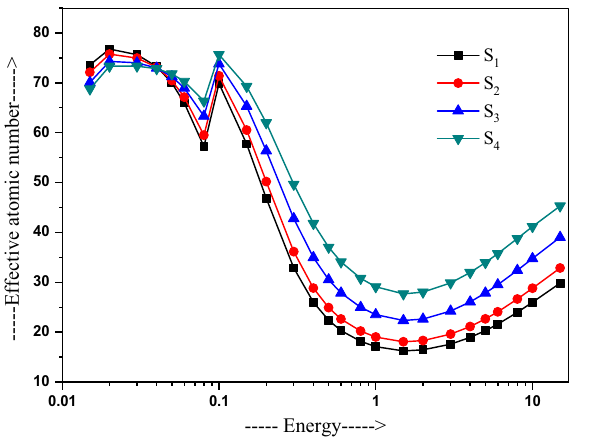
Figure 4. Variation of the effective atomic number with energy in 20Bi 2 O 3 − xPbO − (80 − 2x)B 2 O 3 − xGeO 2 (x = 5, 10, 20, and 30 mol%) glasses.